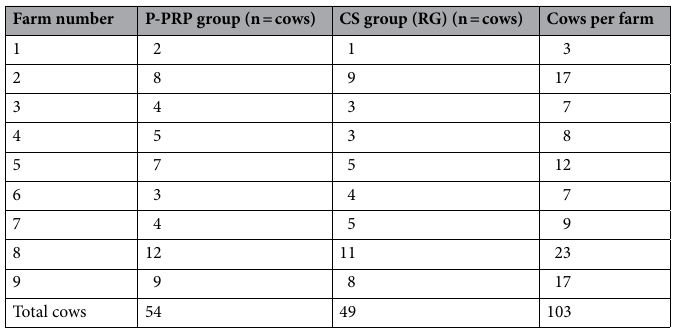
Table 1. Number of subclinical mastitis cases contributed per dairy herd (grouped by treatment). CS cefquinome sulfate, P-PRP pure platelet rich plasma.